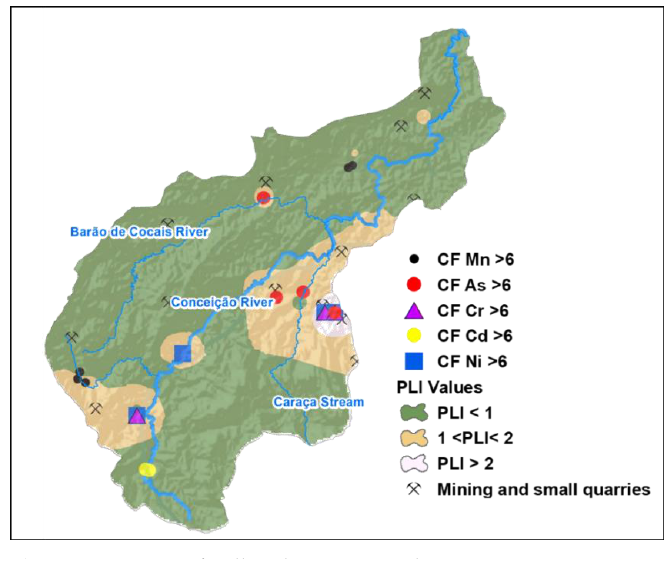
Figure 8. Location of polluted zones, according to PLI [12].